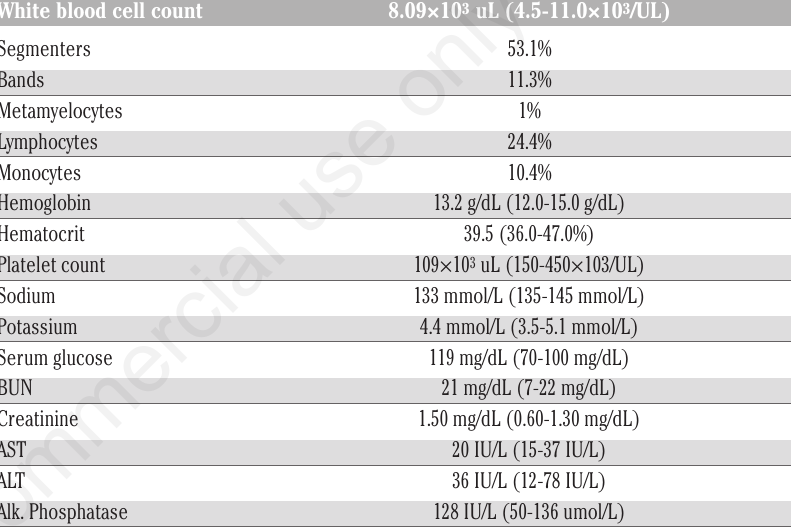
Table 1. Initial laboratory work up.